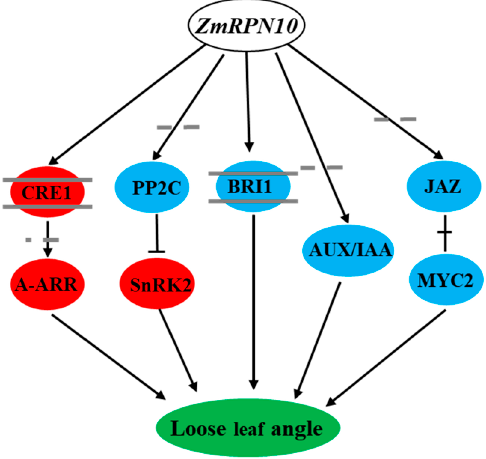
Figure 10. The schematic model of ZmRPN10 regulating maize leaf angle. The red circle indicates that the expression of related genes in rpn10 is higher than B73, and the blue circle indicates that the expression of related genes in rpn10 is lower than B73.